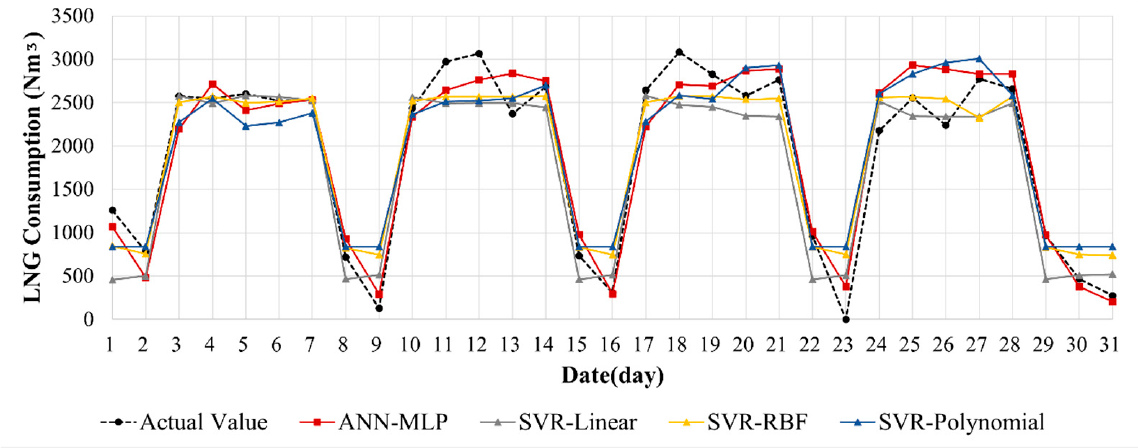
Figure 15. Measured and predicted values for the LNG consumption (1 to 31 January 2022).